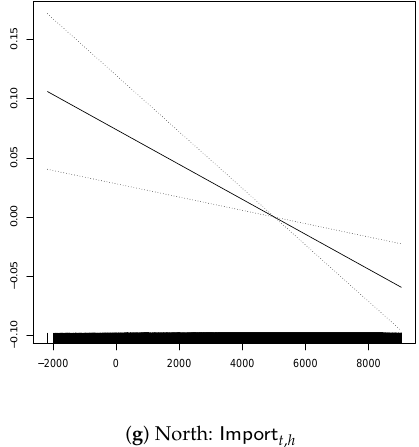
Figure 11. In-sample estimation results of the non-parametric additive model for the conditional variance of electricity demand. For both zones, each panel plots the estimated function f j ( · ) the lagged demand ( D t − 1, h ), for the lagged squared residual (log Import variable ( Import t , h ) but only for the northern